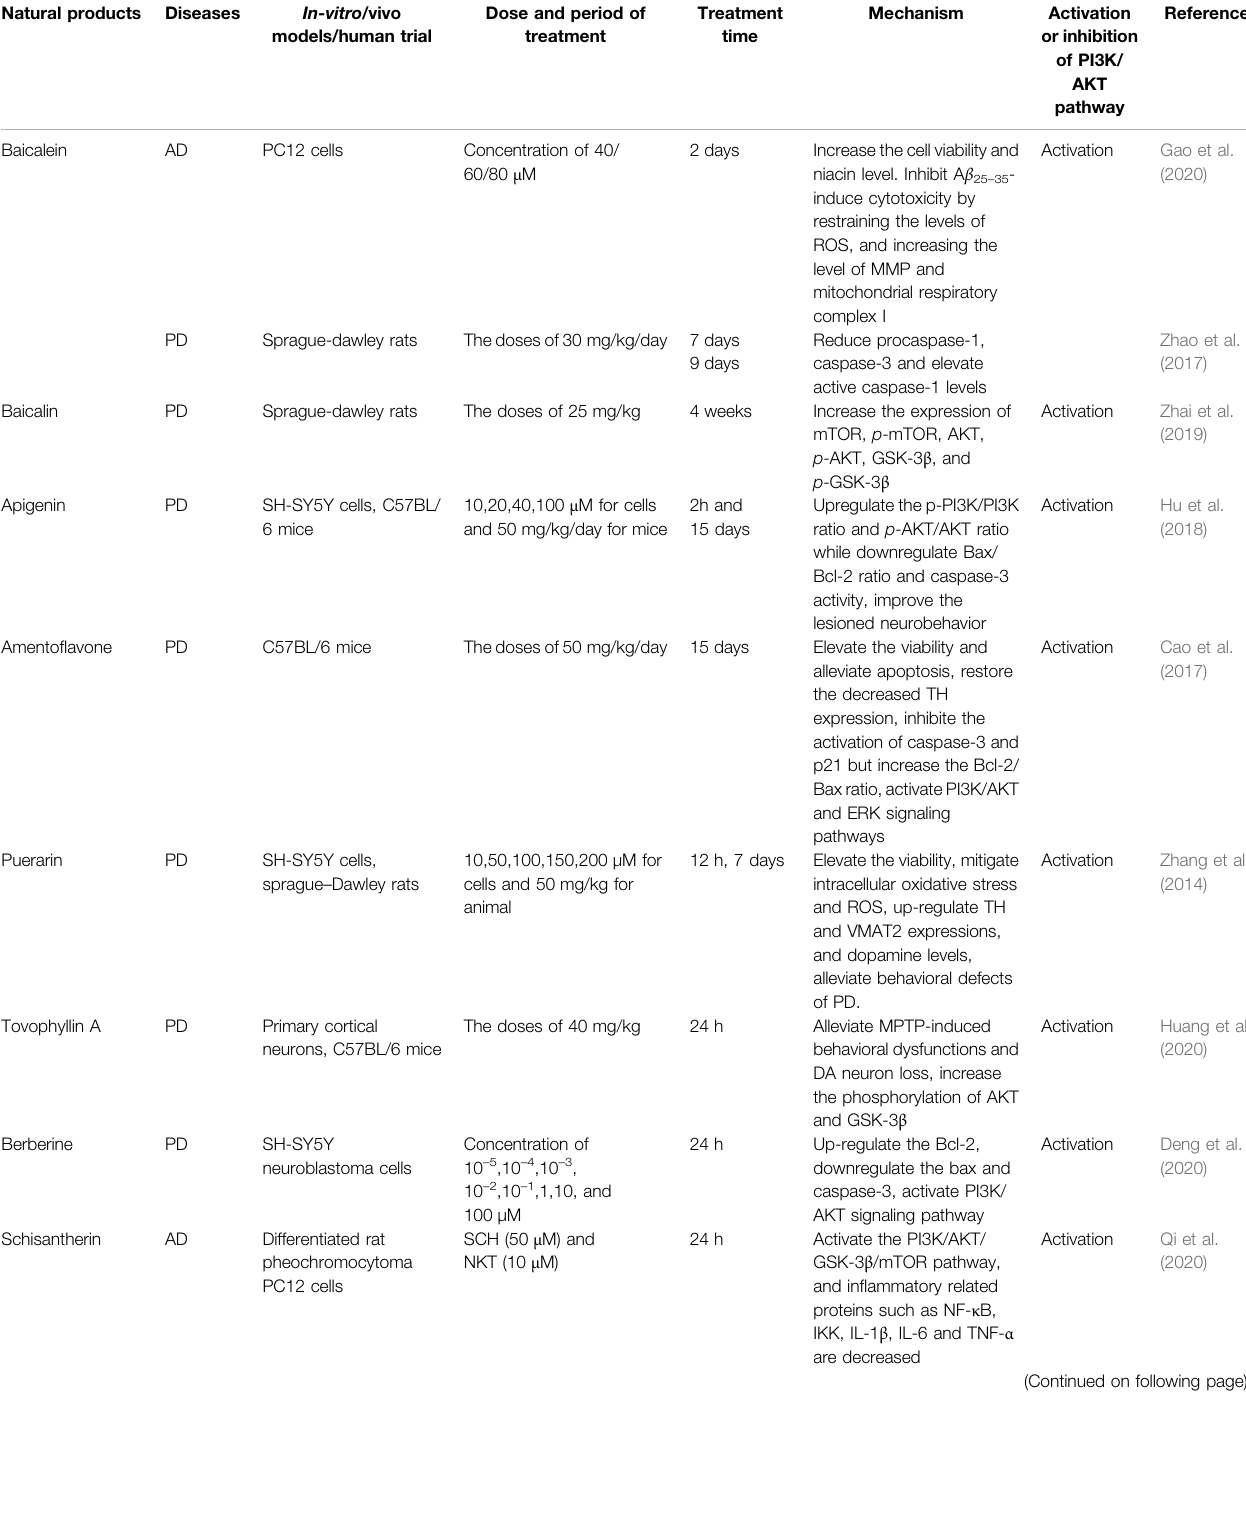
TABLE 1 | ( Continued ) Summary of some natural products with AD and PD therapeutic